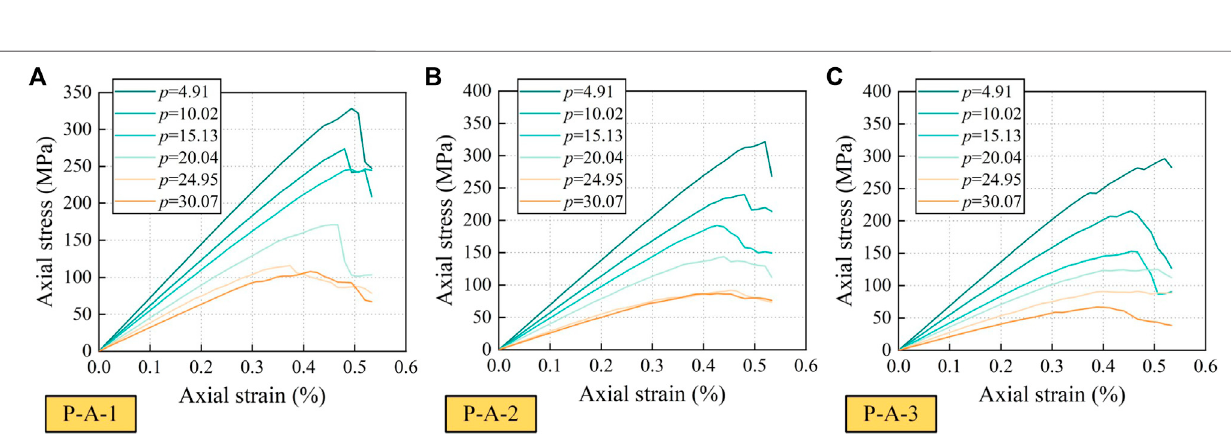
Frontiers in Materials |